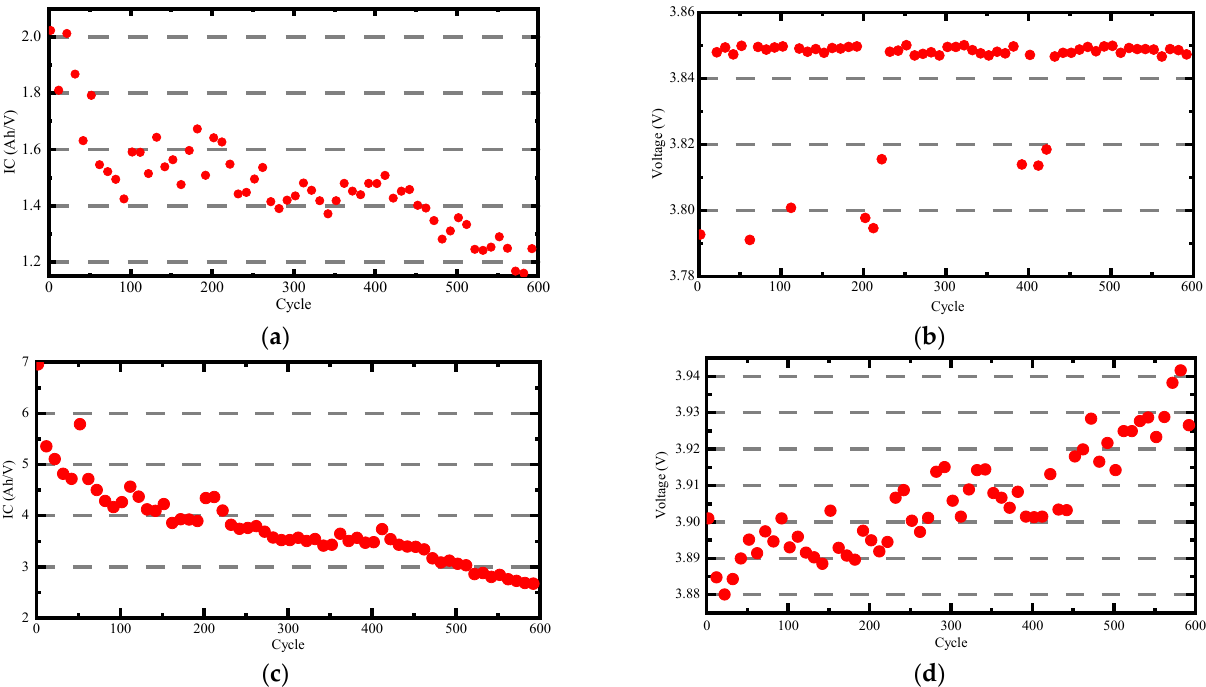
Figure 4. CS2–35 battery aging trend and HI extraction . ( a ) Trend of IC curves of different cycles of CS2–35; ( b ) schematic of IC curve HIs.